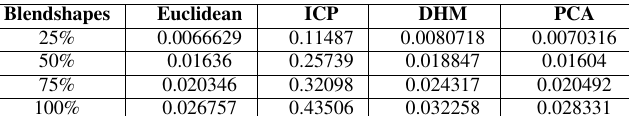
TABLE II R ESULTS IN SECONDS OF THE PROCESSING OF THE BLENDED SETS ACCORDING TO THE TIME OF EACH ALGORITHM